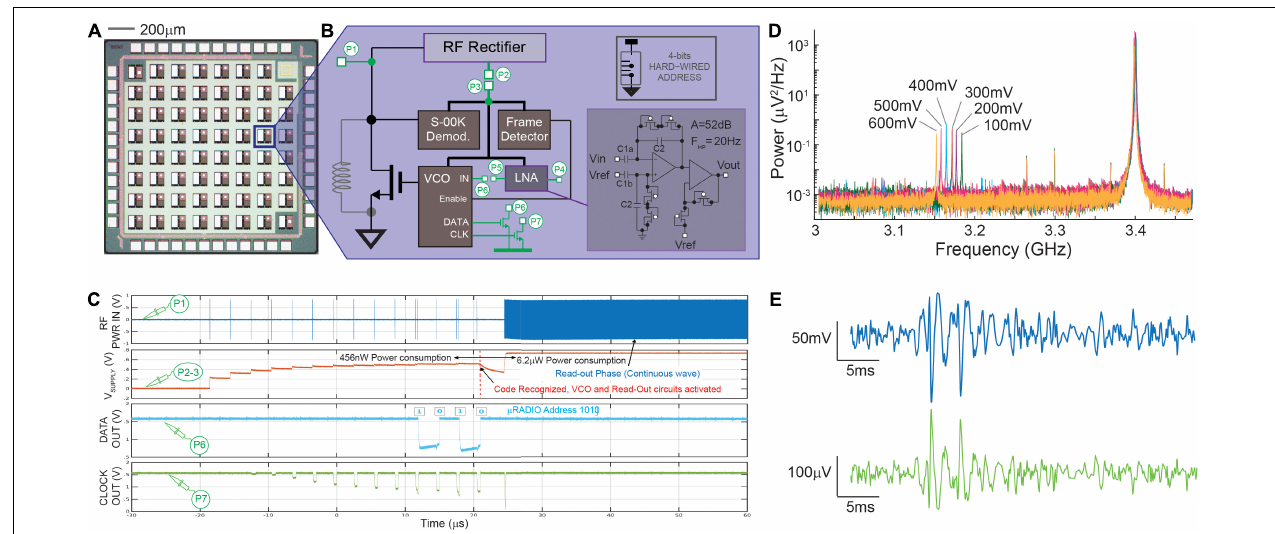
FIGURE 2 | CMOS µ RADIO. Panel (A) Image of a chip prototype integrating multiple instances of a 100 × 100 µ m 2 µ RADIO, two of which include additional circuits for testing purposes. Panel (B) block diagram of the µ RADIO showing in green test circuits that are connected to IO pads (test point P1–P7) and, inset, circuit schematic of the AC-input low-noise bio amplifier. Panel (C) analog waveforms previously reported in Angotzi et al. (2019b) measured on different circuit nodes from a device under test for distinct modes of operation (power up addressing, readout). Panel (D) Power distribution of the backscattered signal measured on node P1 for different voltages applied at the input of the voltage controlled oscillator (P6). Panel (E) post-layout simulations of the demodulated VCO output (top, blue trace) when the Low Noise Amplifier is stimulated with a synthetic neural trace (bottom, green trace).